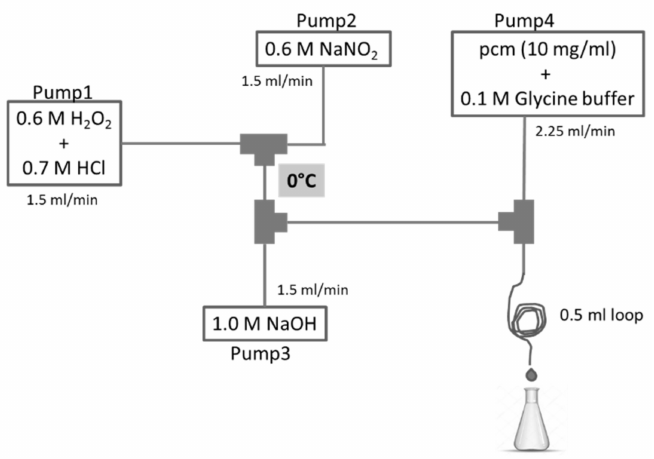
Figure 1. Experimental setup of the preparation of peroxynitrite and its reaction with the hydroxycinnamates of methyl- p -coumarate ( pcm) or methyl-ca ff eate ( cm)